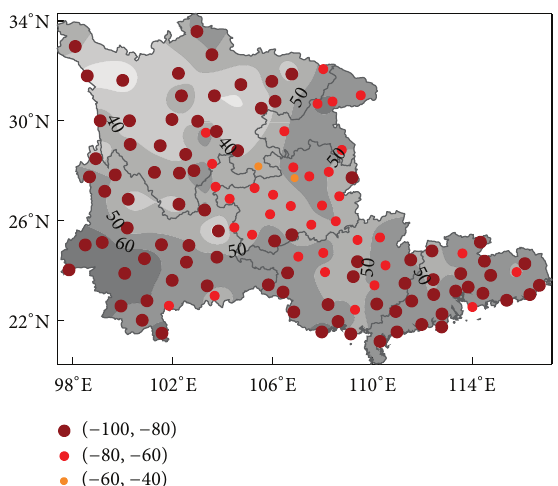
Figure 8: Weighting precipitation deficit (colored dot, unit: %) and the percentage of droughts accounted for by each deficit (blank map, unit: %). The timescale is 1 month.